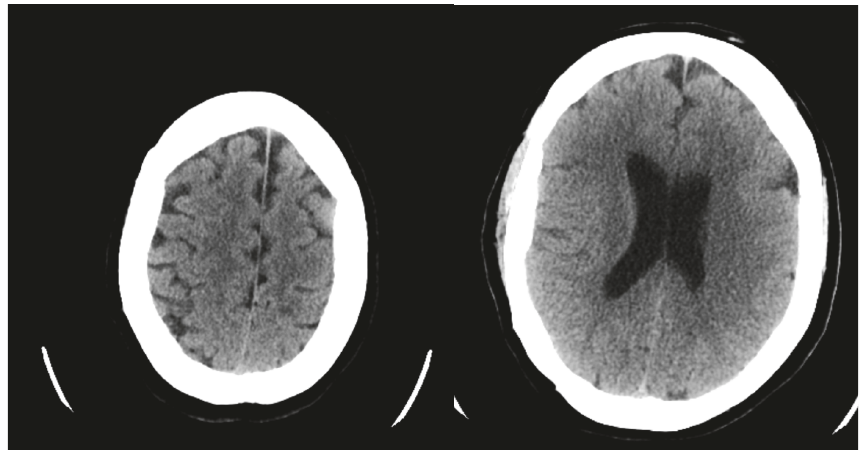
Figure 1: Brain CT on presentation.